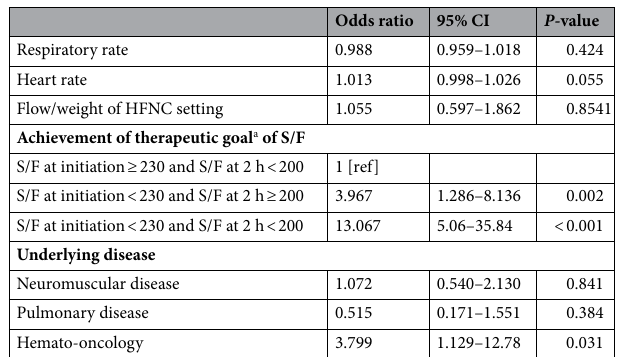
Table 3. Univariate analysis of predictive factors for HFNC failure. Data are expressed as odds ratios with 95% confidence intervals. HFNC, high flow nasal cannula; S/F: SpO 2 /FiO 2 . a Therapeutic goal: S/F ≥ 200 after initiation of HFNC.